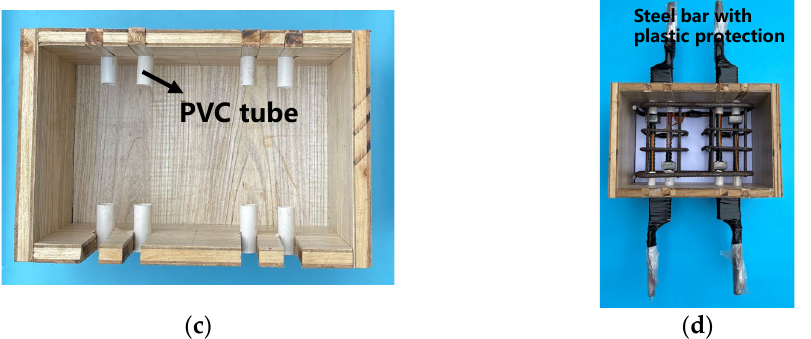
Figure 3. Production of specimens ( a ) Steel bar with head plate; ( b ) Strain gauge operation; ( c ) Mold; ( d ) Fabricated specimen.